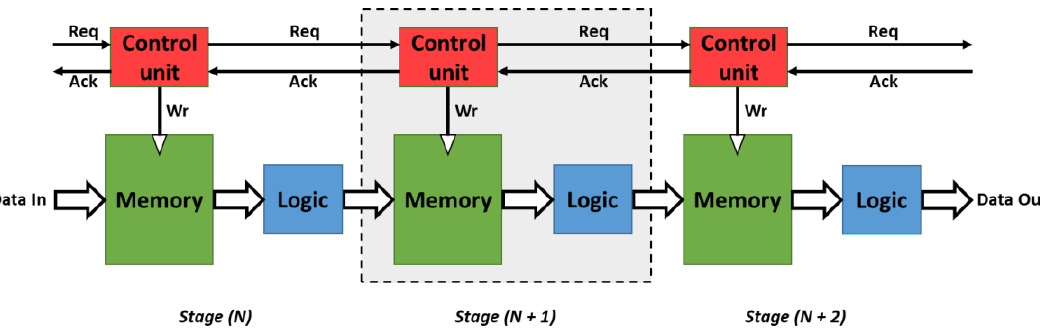
Figure 3. Basic micropipeline circuit. Each stage consists of a control unit and a process unit. The communication protocol between two stages is ensured by request and acknowledge signals.